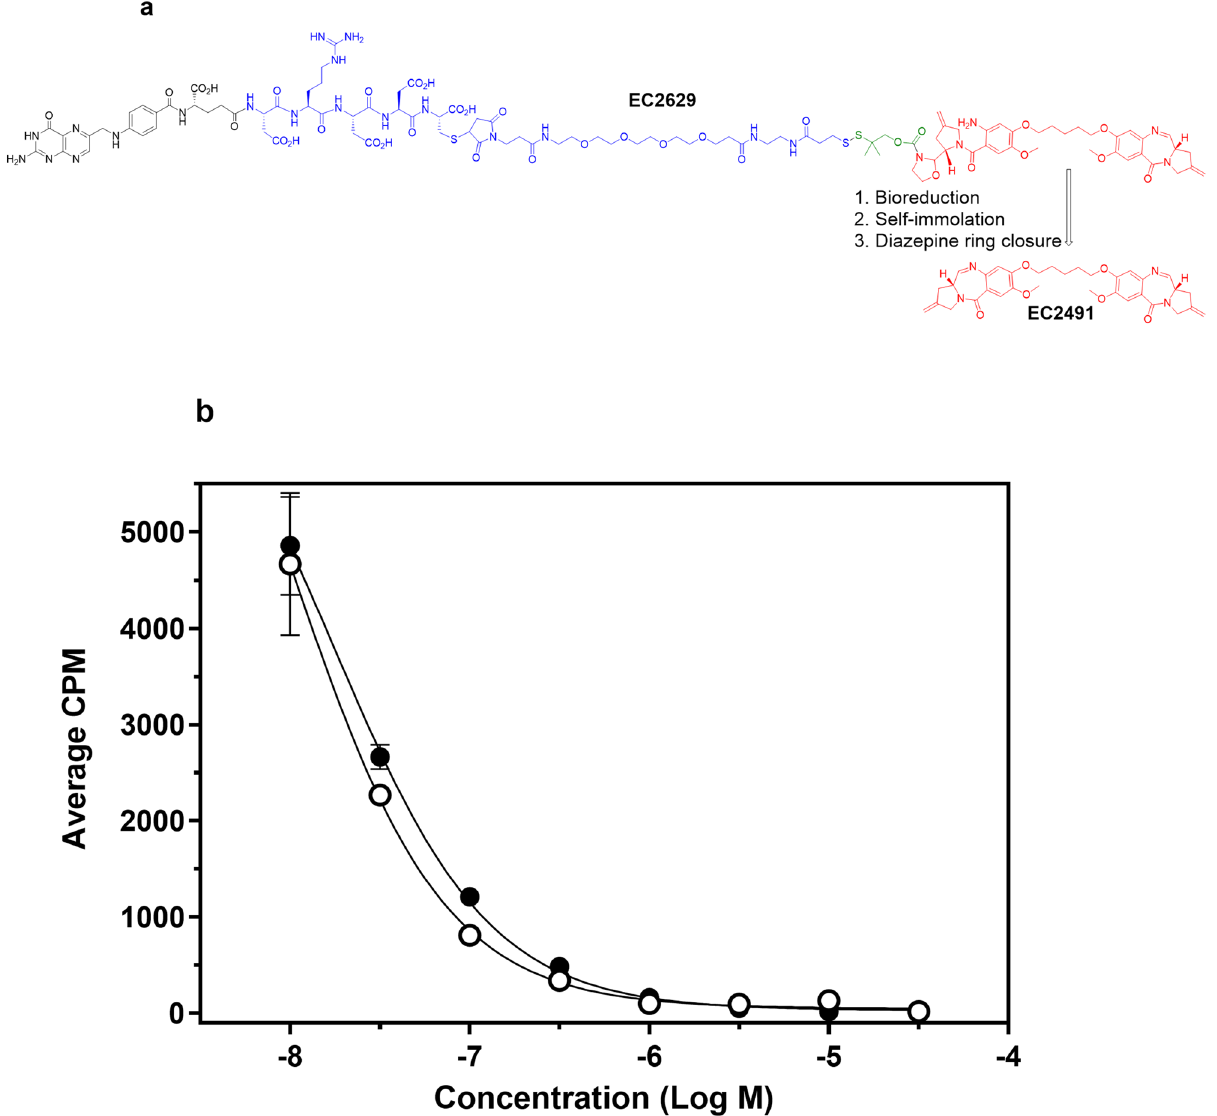
(in green) is a bio-cleavable, self-immolative protected disulfide-based linker system. Module 4 (in red) is a pro-PBD which when released after disulfide reduction forms the PBD dimer agent, EC2491. ( b ) KB cells were incubated for 1 h at 37 °C with 100 nmol/L [ 3 H]-FA in the presence of increasing competitor concentrations. open circle, FA; filled circle, EC2629 and cell associated 3 H measured. Points , average CPM of three wells; bars, standard deviation